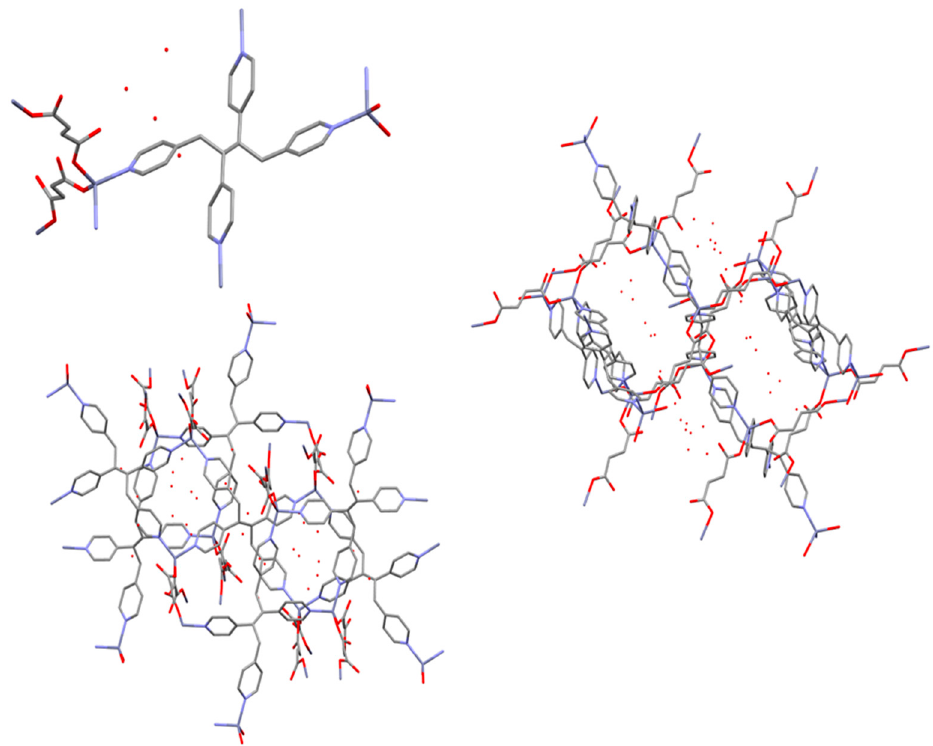
Figure 5. Molecular structure of [Zn(tpb)(fu)] ¨ 2H 2 O and 3D network [67]. (Zn, N, O).